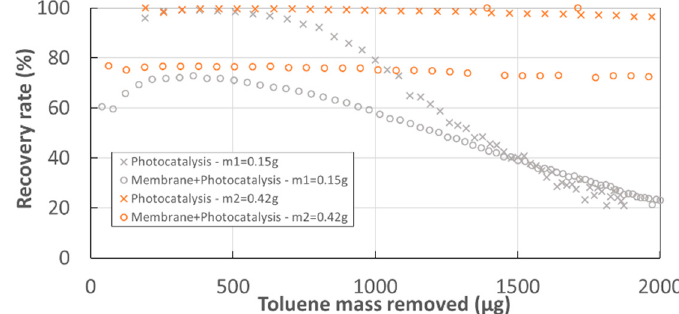
Figure 8. Toluene recovery ratio vs. toluene mass removed for catalysts m 1 and m 2—PDMS mem- brane Sweep gas = 0% − I abs = 6.9 W m − 2 − ψ = 0.98/2.